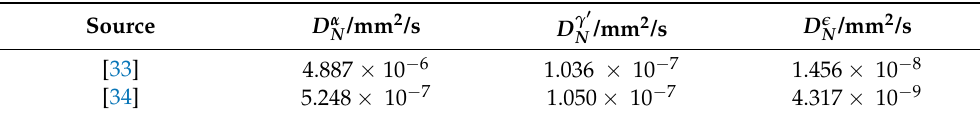
K ) , data from [33,34] for 520°C. ·